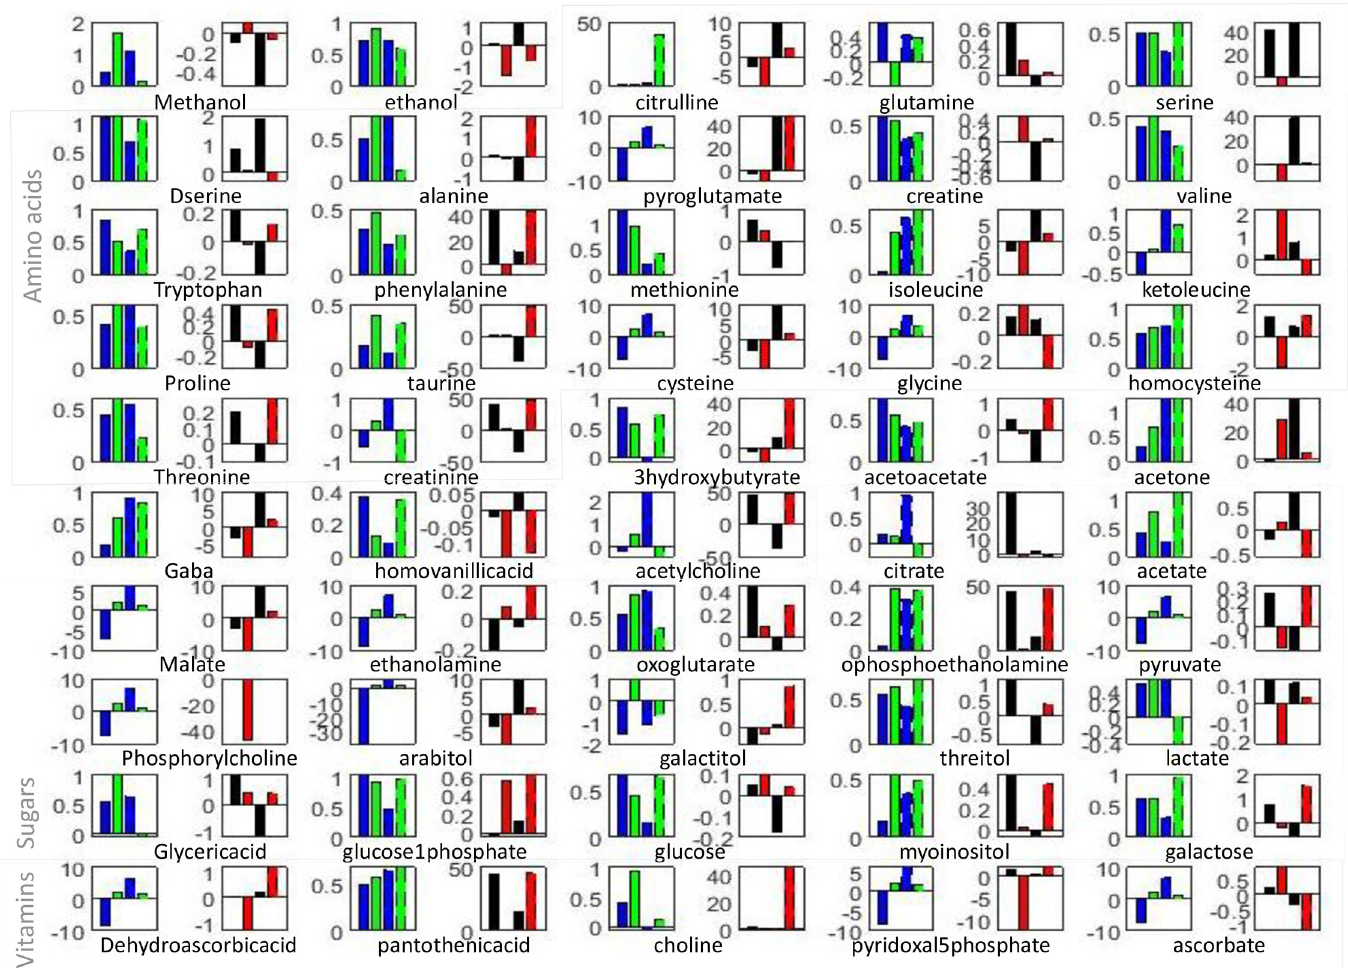
Fig 4. Bar plot of the Log of the ratio between early and late time points metabolite concentrations in blood (WT blue/APP/PS1 green) and CSF (WT black/APP/ PS1 red). Female mice values are indicated with dashed lines (second pair on the